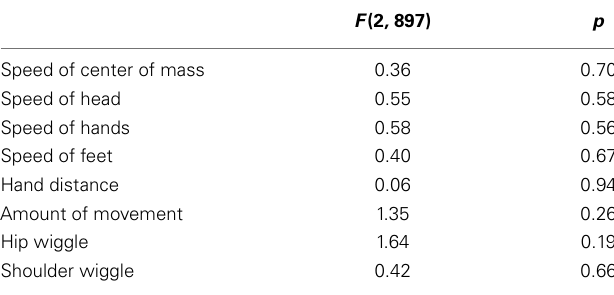
Table 3 | Results from the series ofANOVAs, testing for differences in the movement features between the three tempo